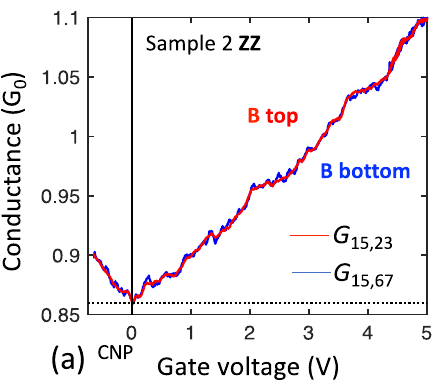
with a 1D edge state that involves both edges coherently and not with a top edge that is independent of the bottom edge which would cause the conductances, especially at CNP to be very different (see